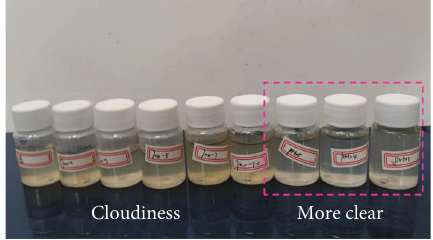
Figure 8: Sludge suspensions at di ff erent treatment